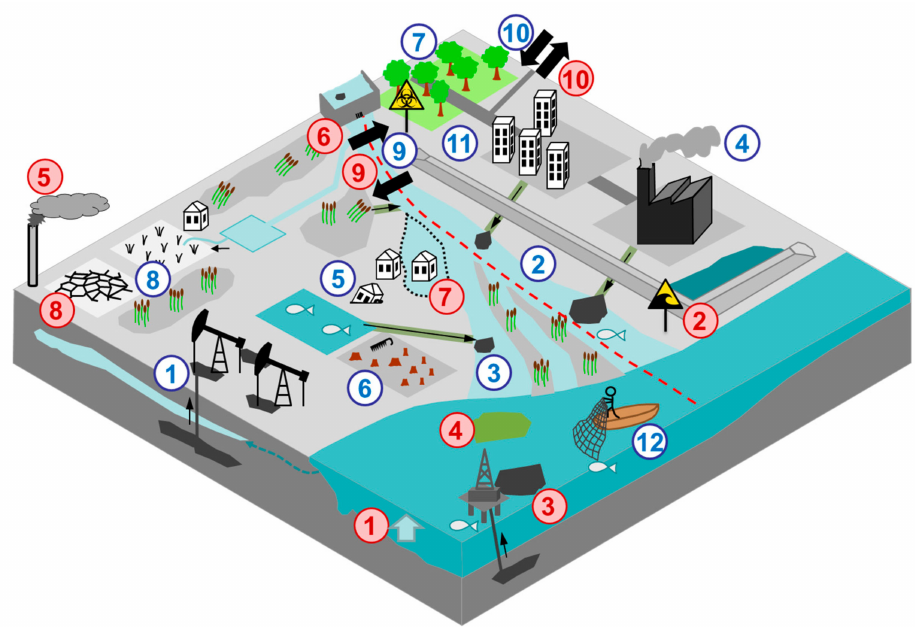
Figure 2. Major external (red) and internal (blue) threats generic to most settled river delta